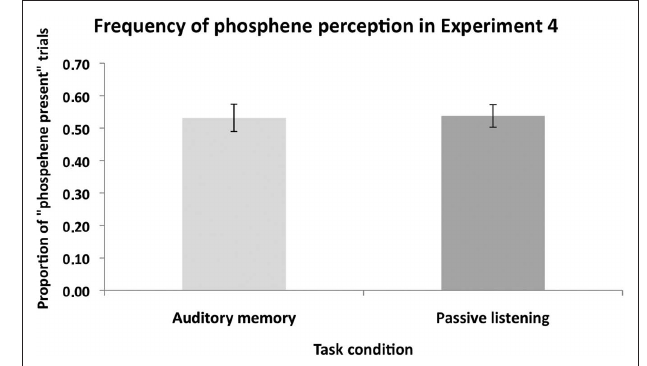
Figure 7 | The mean ( n = 11) proportion of “Phosphene present” judgments in experiment 4. There was no significant difference in the proportion of perceived phosphenes between the “auditory memory” and “passive listening” conditions. This shows that non-visual cognitive load did not modulate the excitability of the visual cortex. Error bars represent ± 1